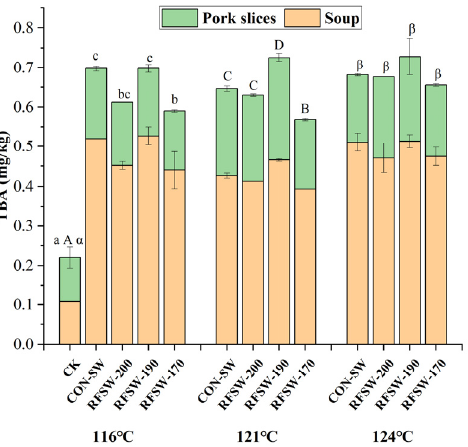
Figure 7. Thiobarbituric reactive substances of poached spicy pork slices sample sterilized by RFSW under different electrode gaps and superheated water temperatures. Different lowercase letters (a–f, A–D, and α , β ) indicate significant differences ( p < 0.05) within the different temperatures of 116 ◦ C, 121 ◦ C, and 124 ◦ C. CK means unsterilized poached spicy pork slices; RFSW means radio frequency combined superheated water at a certain electrode gap; CON-SW means superheated water sterilization